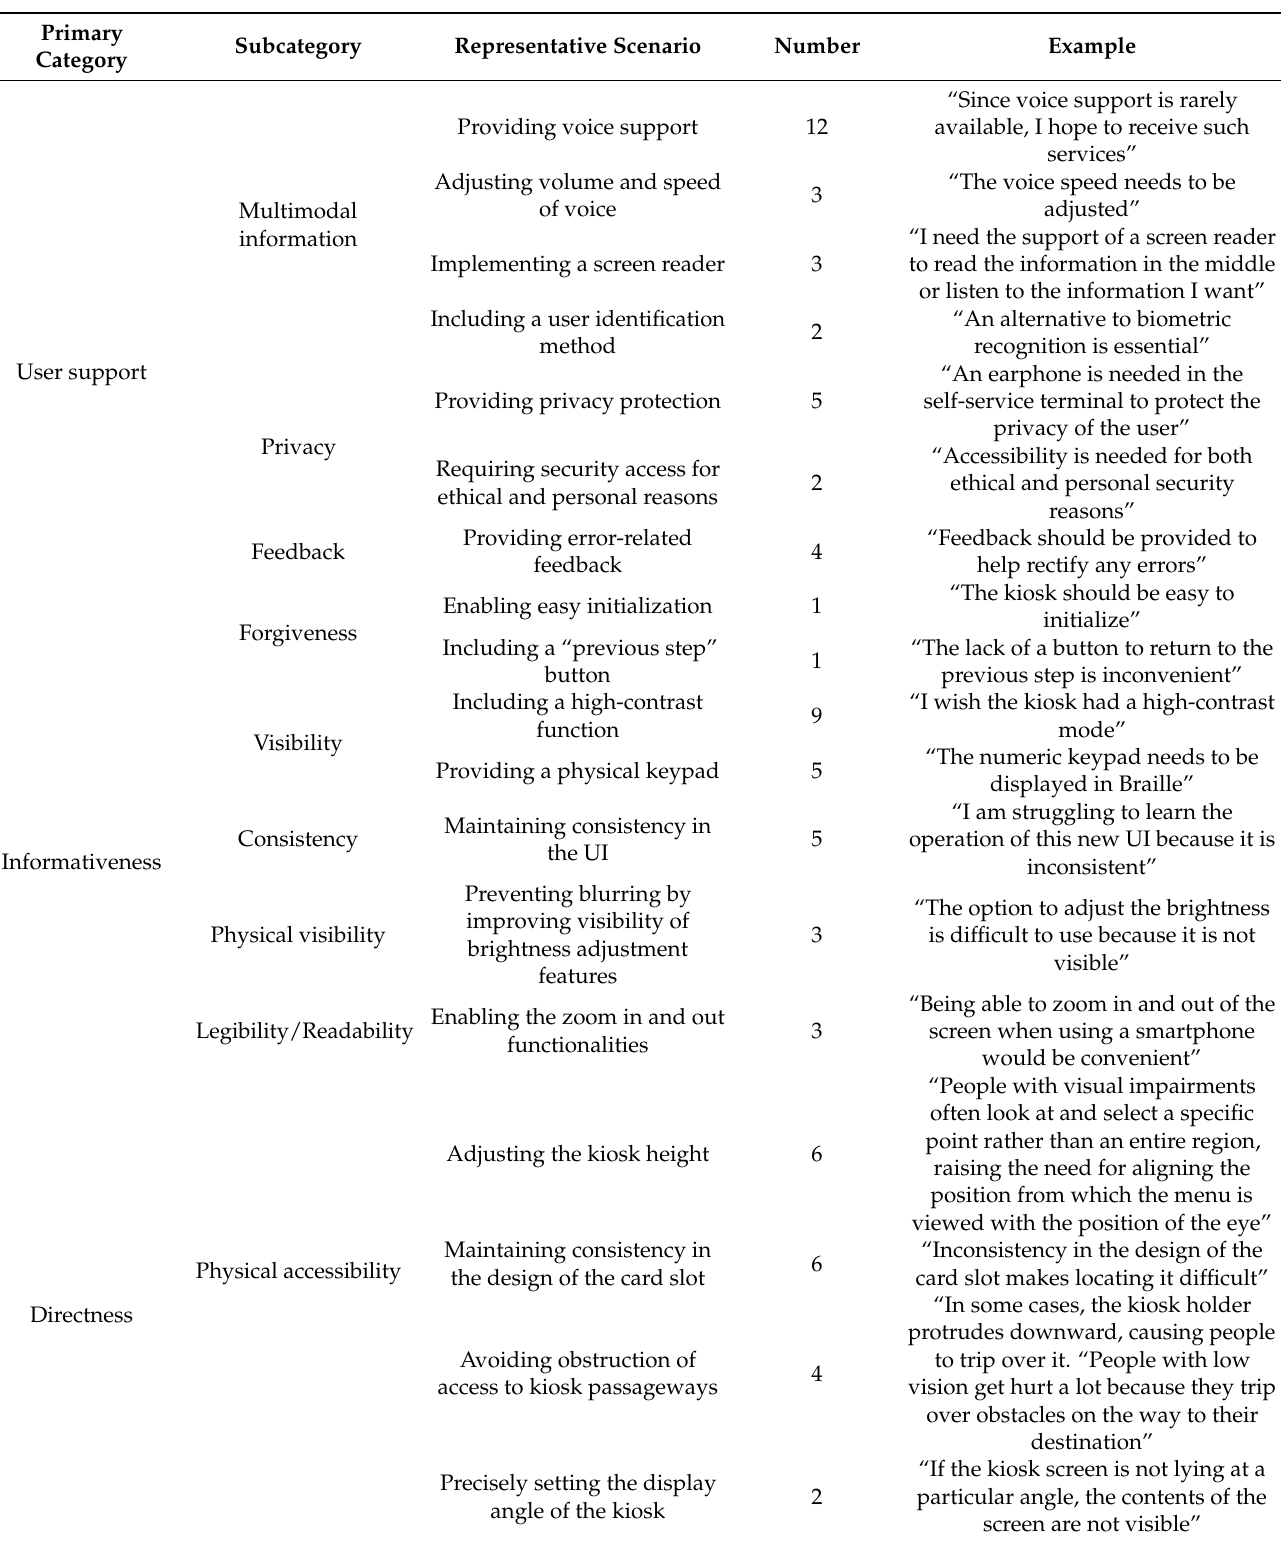
Table 3. Accessibility items for participants with visual